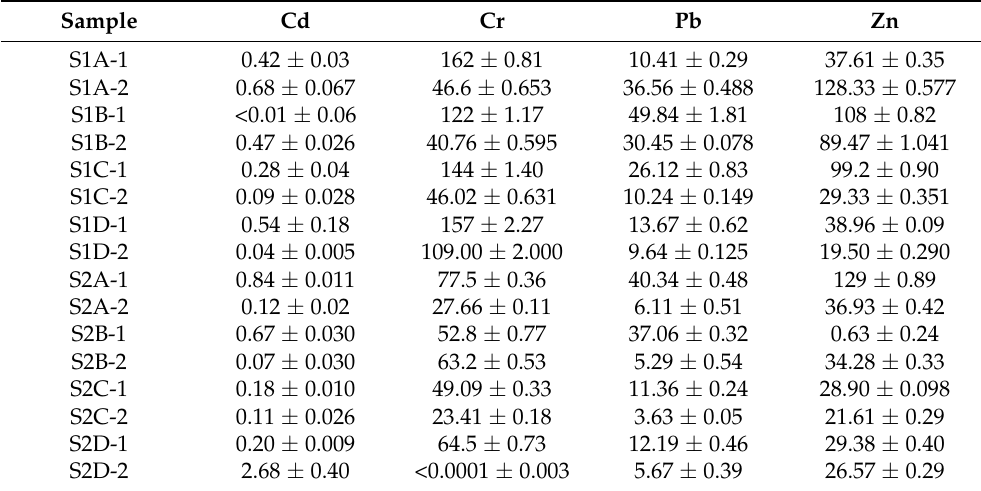
Table 4. Selected heavy metals in the studied soils [mg kg − 1 ]. S1: soil from the limestone open-cast mining remediated with embankment; S2: soil from the lignite open-cast mining remediated with sewage sludge; subsequent letters A–D mean different remediated areas located at the same mine site; subsequent numbers mean different sampling periods; 1: spring 2021, 2: spring 2022. Mean values ± SD, n =